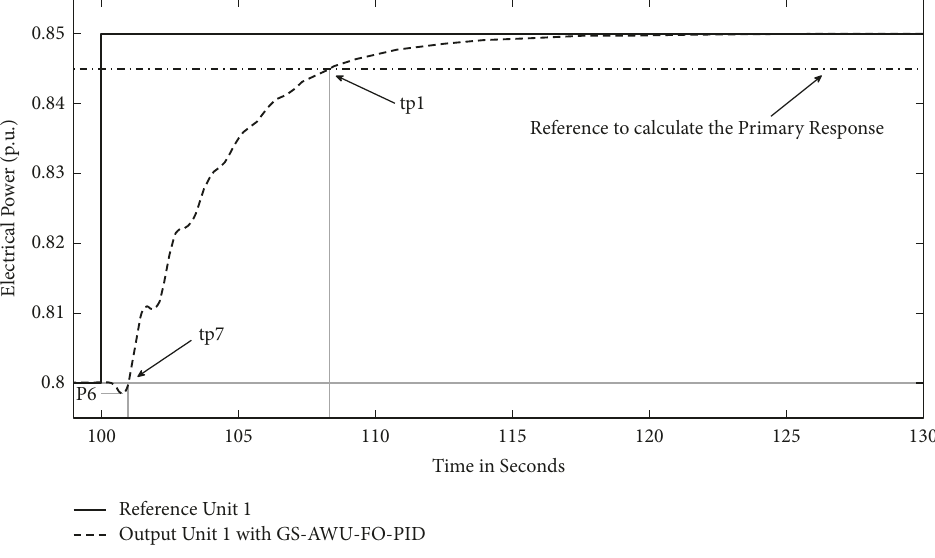
Figure 20: Step response of GS-PDF-FO with antiwindup, one operational unit, and